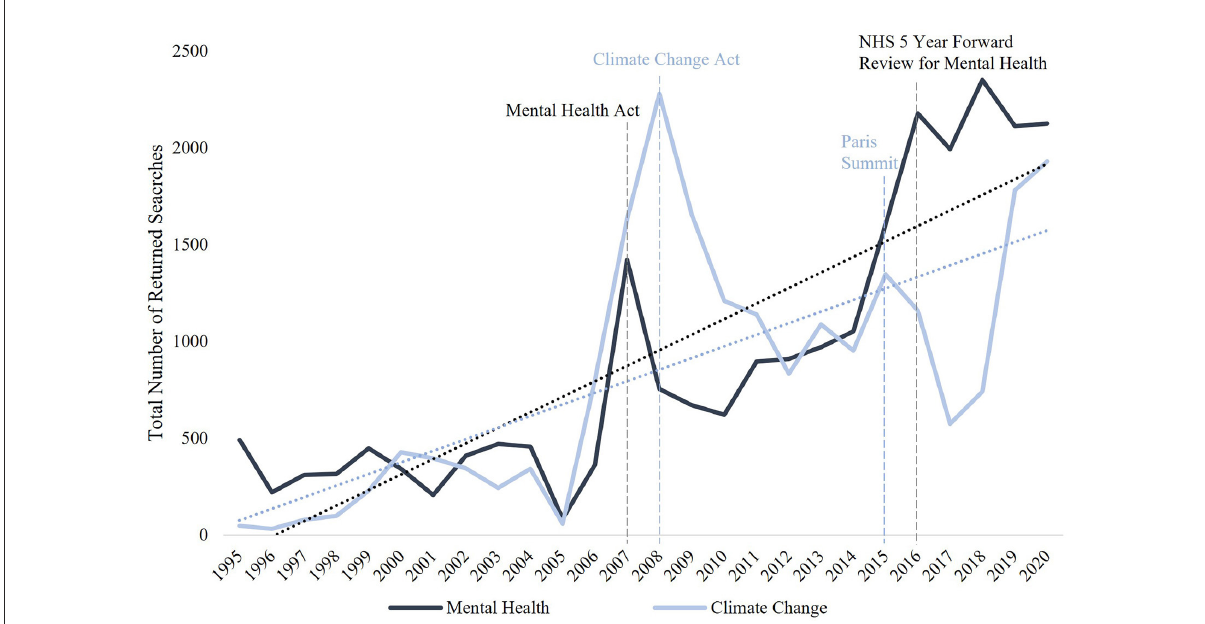
FIGURE2 Increase in frequency of speeches around mental health and climate change within UK parliament over the past 25 years. Total number of returned searches across both the House of Commons and House of Lords was found using a search for the terms ‘climate change’ and ‘mental health’ for each year from 1995 to 2020 (01/01–31/12) on UK Hansard database. Key reports/events included as references. Linear trend lines show the overall trend in this change.